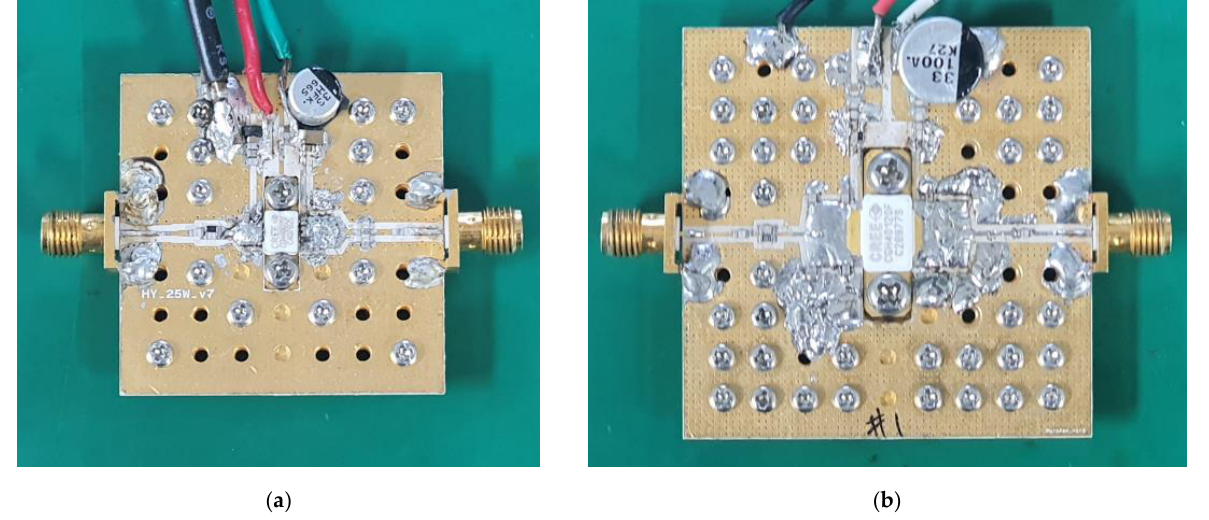
Figure 2. Photographs of ( a ) the drive and ( b ) the main PA test unit.